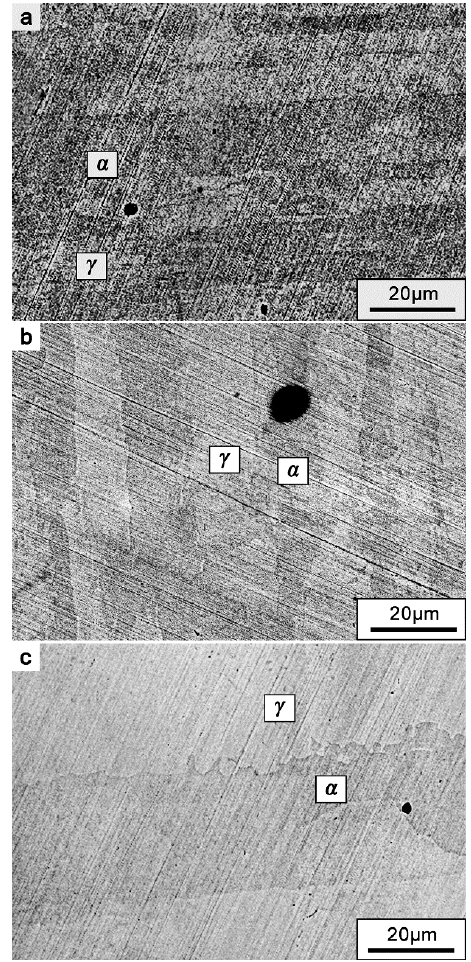
Figure 18. BSE image of metastable pit position on different surface roughness DSS 2205 specimens: ( a ) 180#; ( b ) 1000#; ( c ) polished.